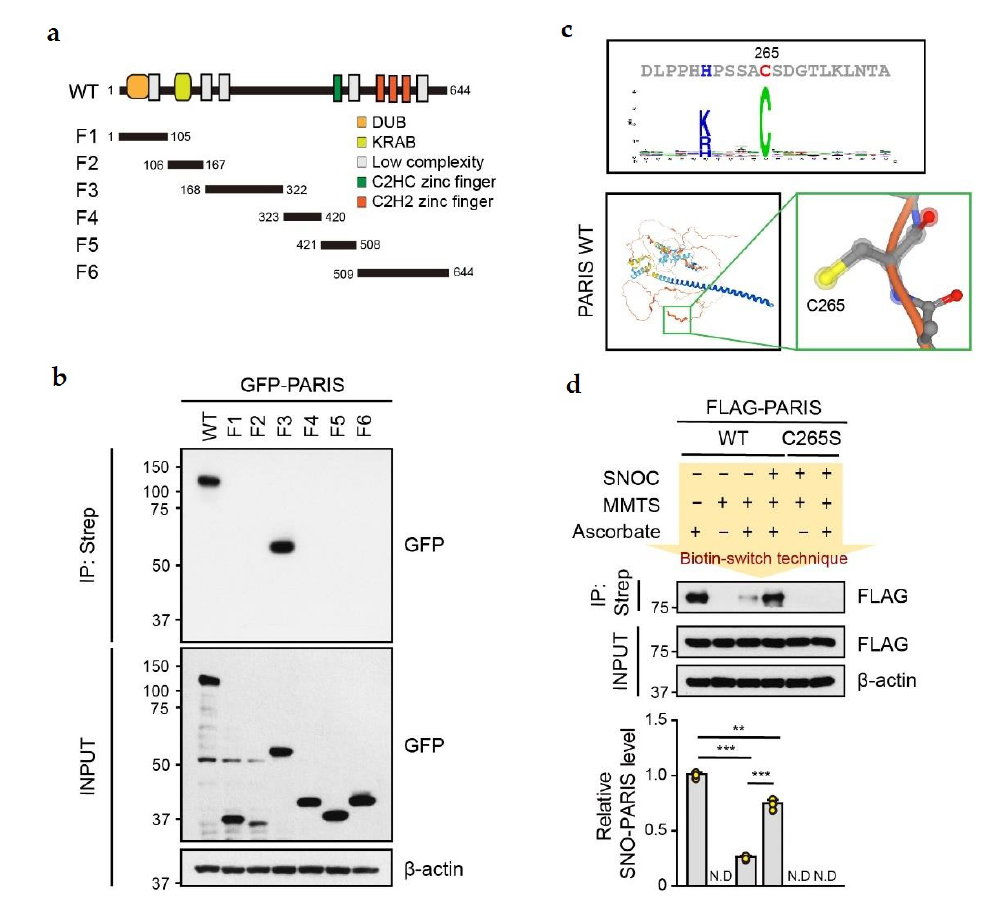
Figure 2. The cysteine 265 residue is an important site for S-nitrosylation of PARIS. ( a ) Schematic diagram of PARIS WT and truncated fragments of PARIS. F1, 1–105; F2, 106–167; F3, 168–322; F4, 323–420; F5, 421–508; F6, and 509–644. ( b ) Representative immunoblots showing S-nitrosylation of PARIS WT and F3 truncated fragment. Lysates from SH-SY5Y cells expressing GFP-tagged PARIS WT and fragments (F1-F6) were exposed to SNOC (50 μM) for 30 min and subject to immunoprecipitation using streptavidin. SNO-PARIS was detected using the anti-GFP antibody. ( c ) Computational prediction suggesting that cysteine 265 residue is the S-nitrosylation site on PARIS. ( d ) Lysates from SH-SY5Y cells expressing FLAG-PARIS WT and S-nitrosylation deficient mutant C265S were incubated with or without SNOC (50 μM) for 30 min, and SNO-PARIS was detected using the biotin switch technique ( n = 3) and one-way ANOVA was followed by Tukey’s multiple comparison test, ** p < 0.01, *** p < 0.001, N.D, not detected.